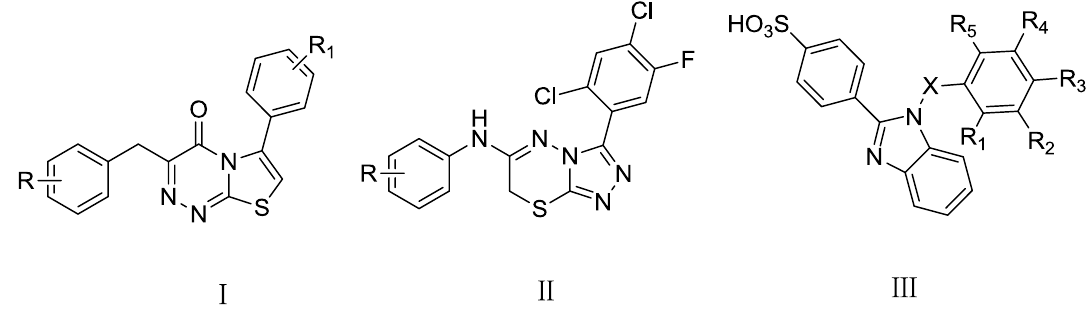
Figure 1. Model compounds with pharmacological